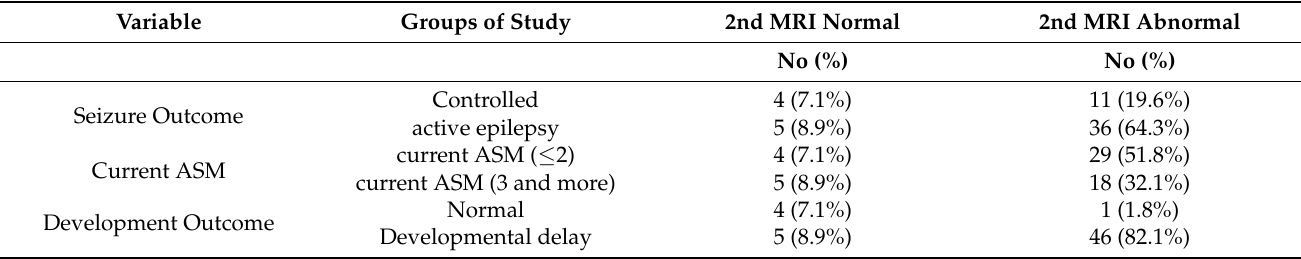
Table 2. Seizure outcome, ASM, GDD and MRI brain relation.